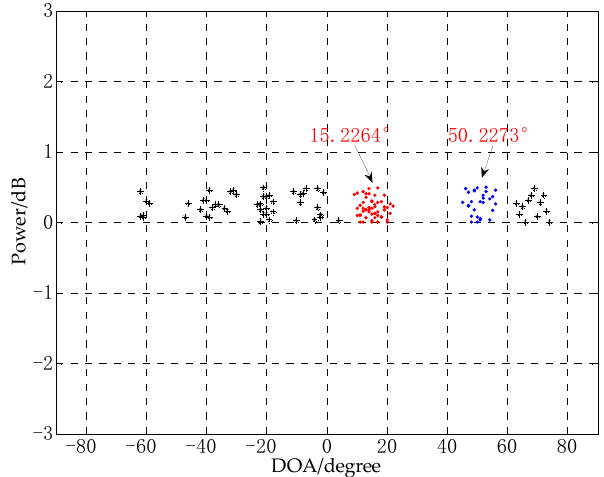
Figure 11. DOA estimation experiment of close angles.